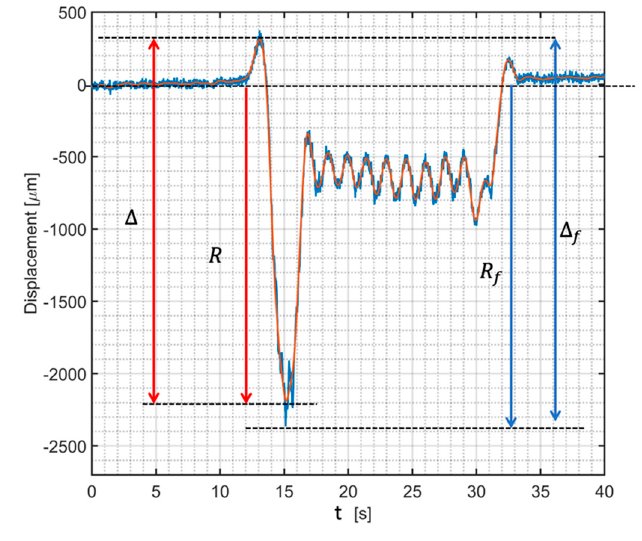
Figure 8. Displacement of the A-point of the plot in Figure 7 (the Veresk Bridge) during the passage of a cargo train.